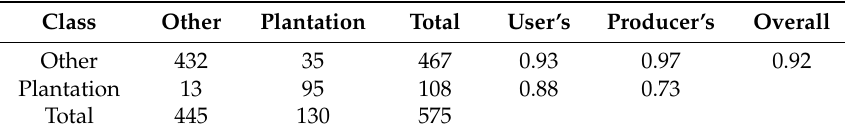
Table 2. Confusion matrix showing the number of samples along with specific accuracy measures calculated from an independent set of reference